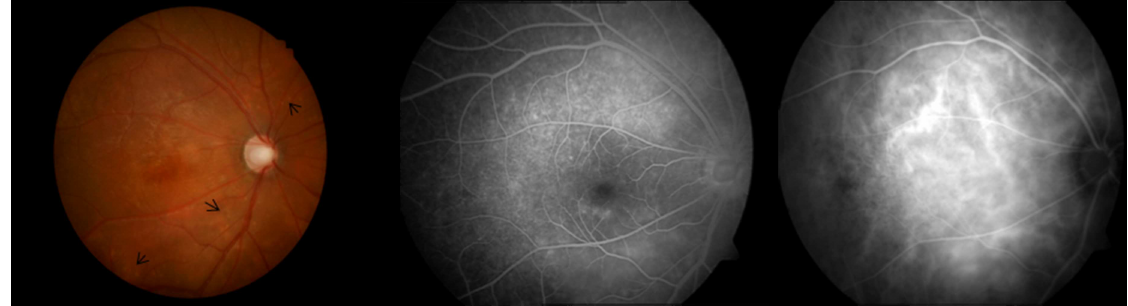
Fig 2. Images of a 22-year-oldmale patient. (2A) Fundus photographdemonstrating increasedcup-to-discratio, RPE irregularities in the macula and the surroundingretina, with yellow-white subretinaldeposits(black arrows). No obviousmacular edemawas observed. (2B) FFA showingpunctuateor patchedhyperfluorescence in the macula and the posterior retina. (2C) ICGA showingmarkedlydilated choroidalvessels in the posterior pole.